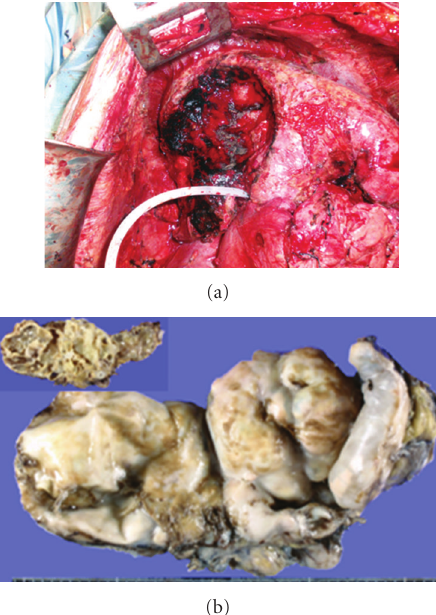
Figure 9: The operative view after enucleating of a large cystic le- sion indenting the liver deeply. The resected specimen of the lesion described in Figure 8.